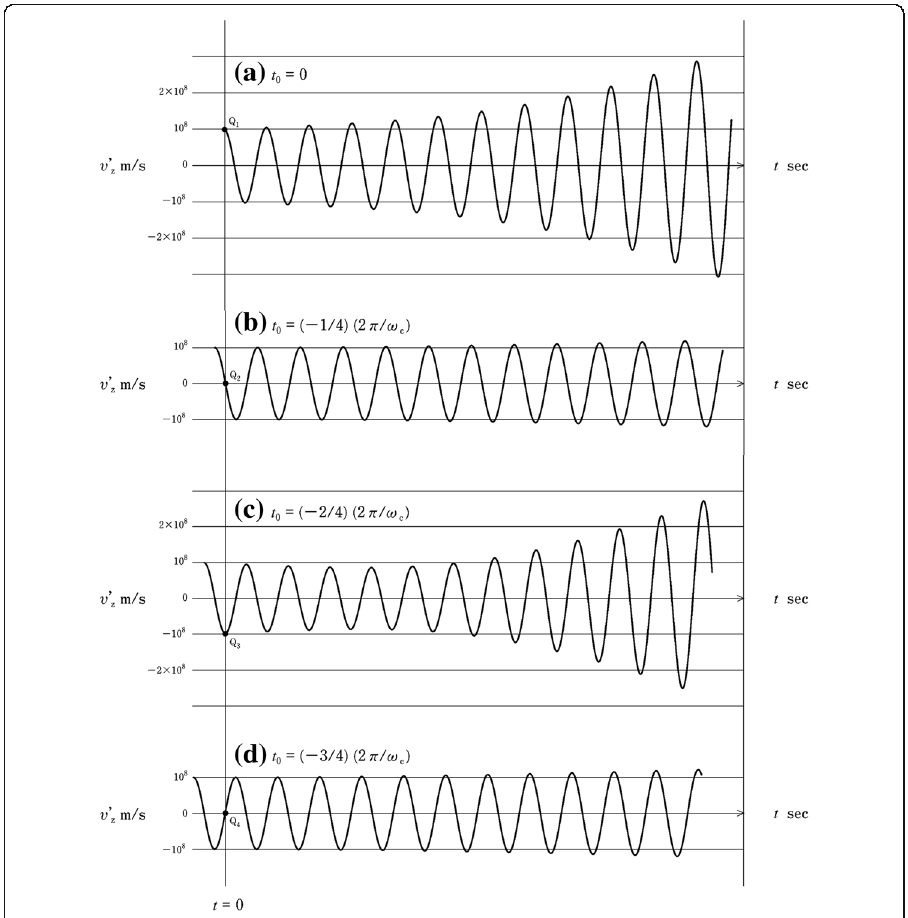
Fig. 1 a-d Dependence of a velocity υ ′ z ( z - component) of a relativistic electron on the phase of an electric field, based on Eq. (12). The physical conditions are: an initial velocity z 0 ¼ j ^ z 10 8 j m/s at time t 0 (written in each of ( a )-( d )), E ( t ) = − ^ z 10 3 cos ω t V = m ; ω c ¼ q j ^ y B jð 1 − z 2 The flight time t = t 0 ~ t 0 +12 (2 π / ω c )